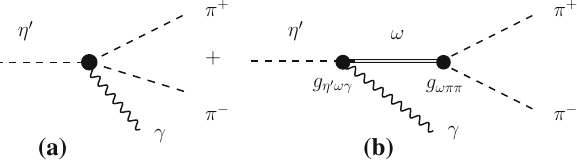
Fig. 2 Diagramscontributingtothereaction η (cid:5) → π + π − γ .Thepions from both diagrams undergo final-state interactions that are not shown